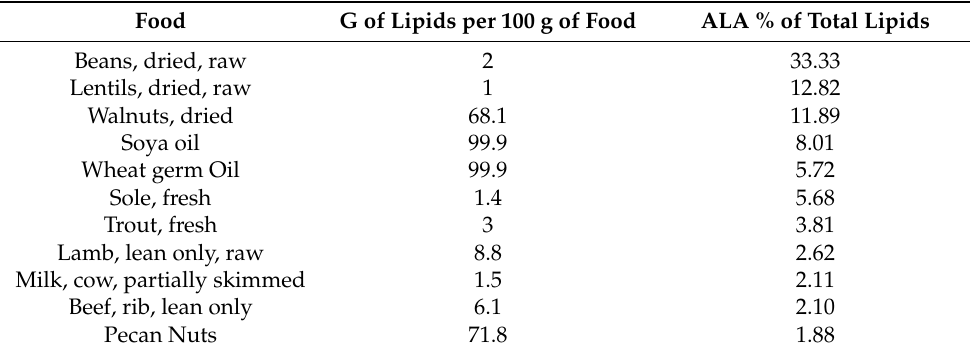
Table 2. α -Linolenic acid (ALA) content of some plant and animal foods. Food G of Lipids per 100 g of